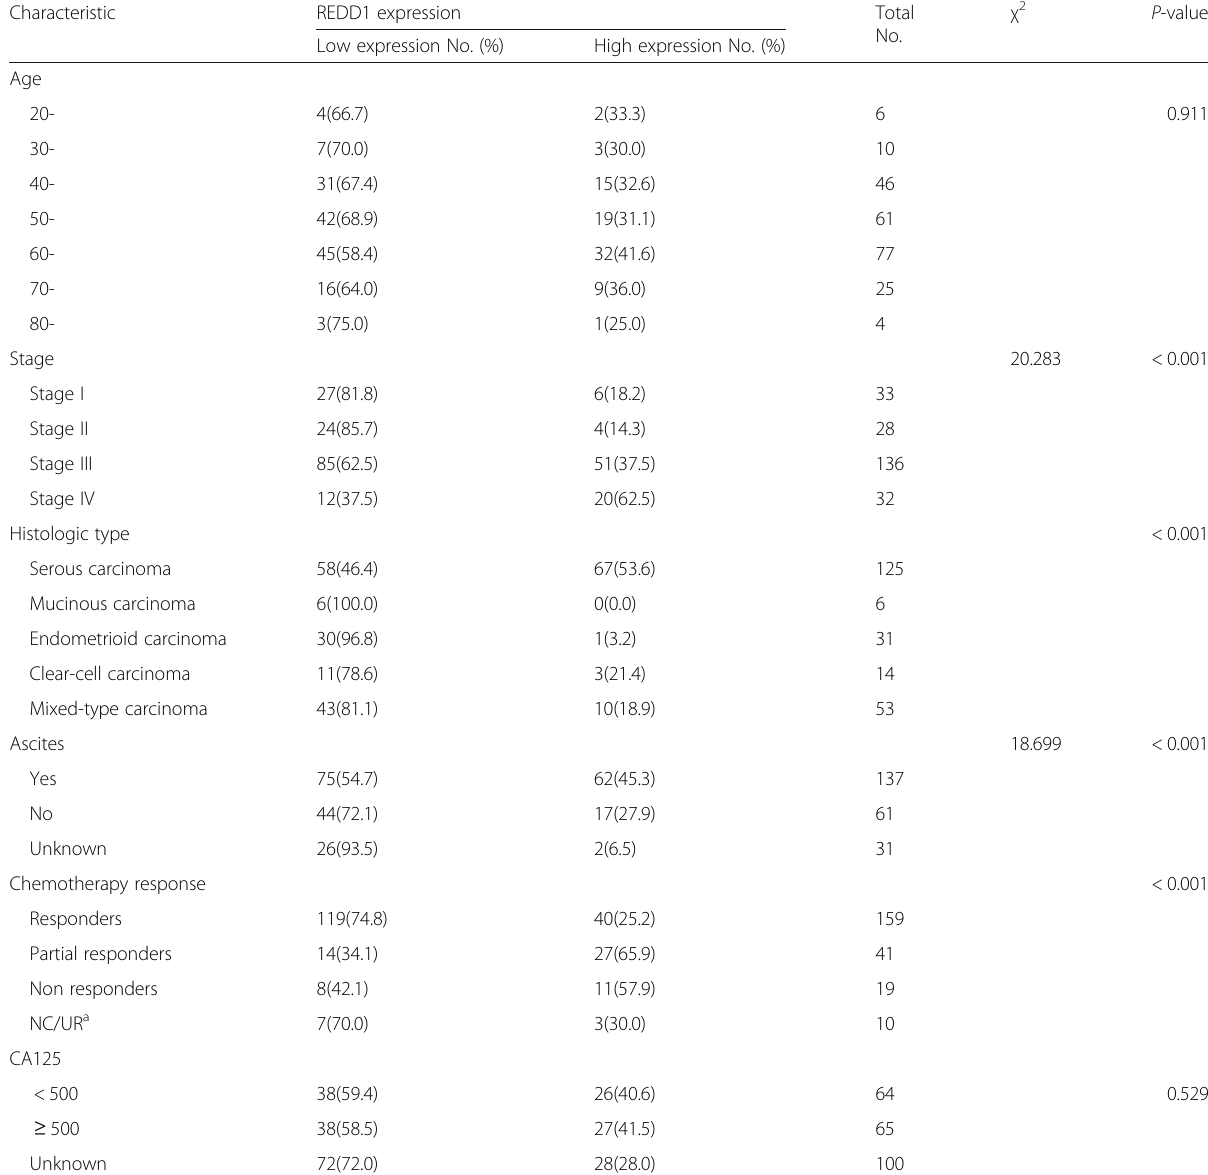
Table 2 Correlation between cytoplasmic REDD1 expression and clinicopathologic factors